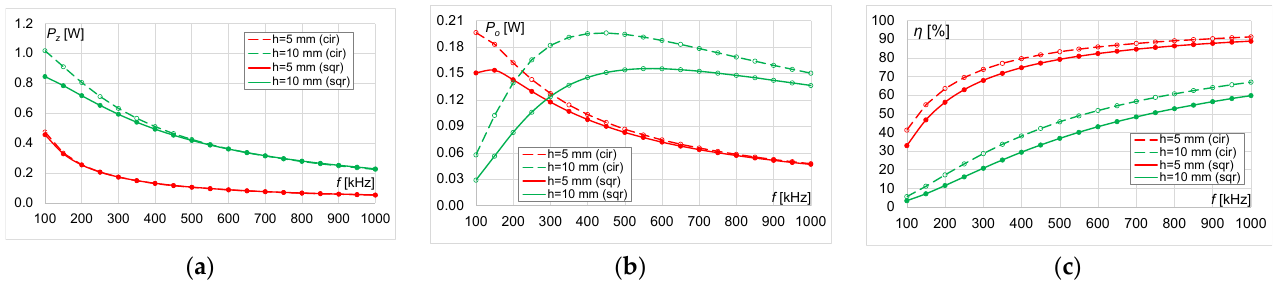
Figure 11. Results for circular and square coils with r = 10 mm and number of turns n = 45 at different distances ( h = 5 mm and h = 10 mm): ( a ) transmitter power, ( b ) receiver power and ( c ) power transfer efficiency.